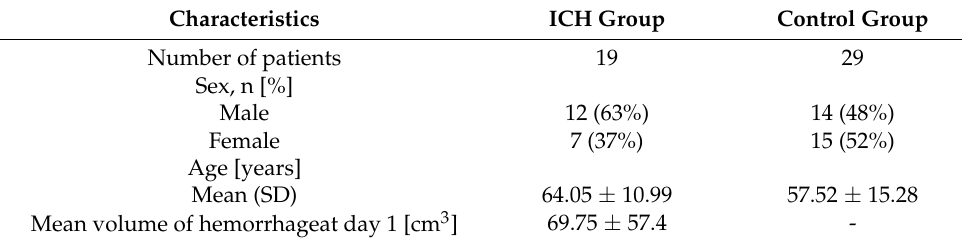
Table 1. Baseline